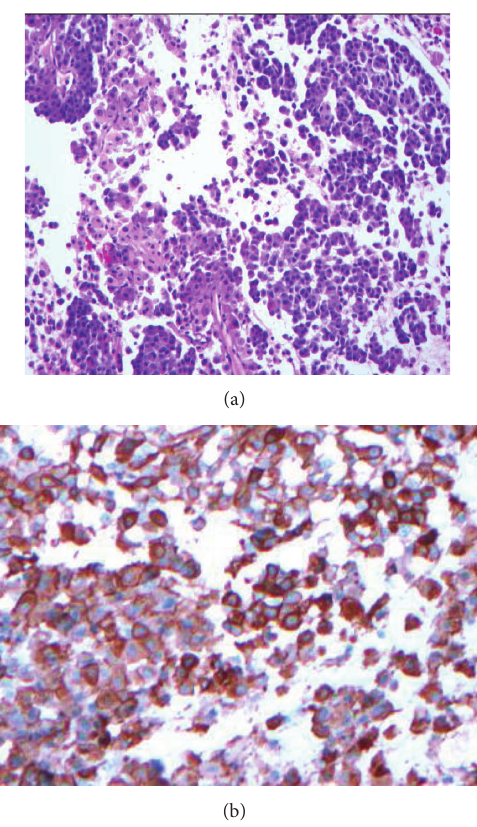
Figure 3: Histology: (a) H&E stain showing basophilic cells at magnification × 200. (b) Positive ACTH